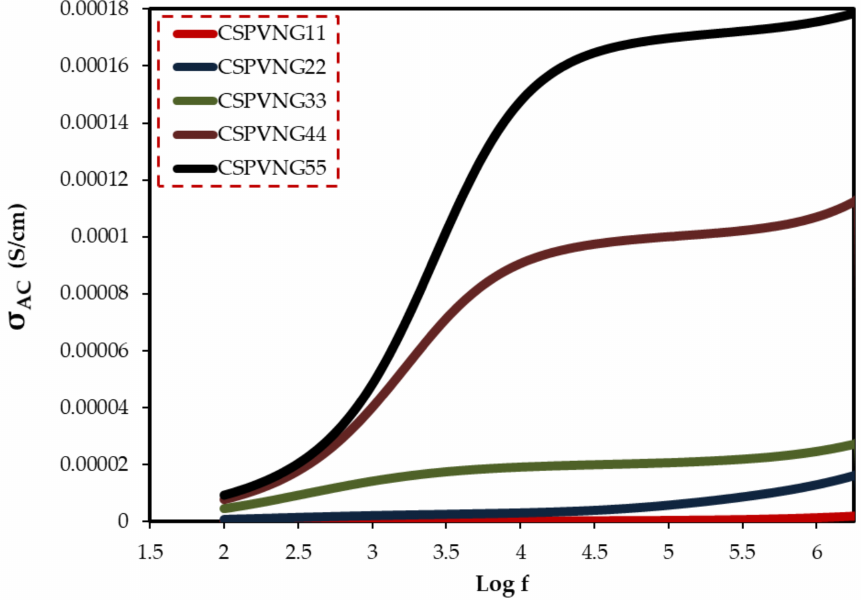
Figure 15. AC conductivity